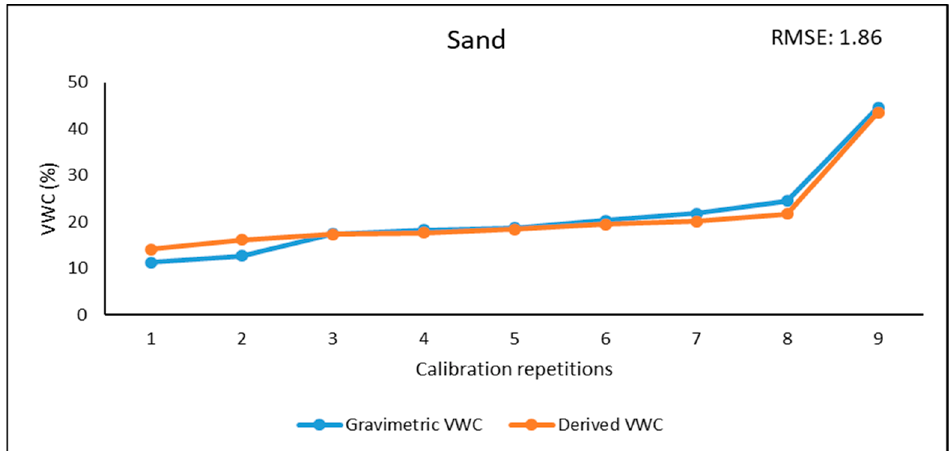
Figure 8. Sand Gravimetric VWC compared with derived VWC.